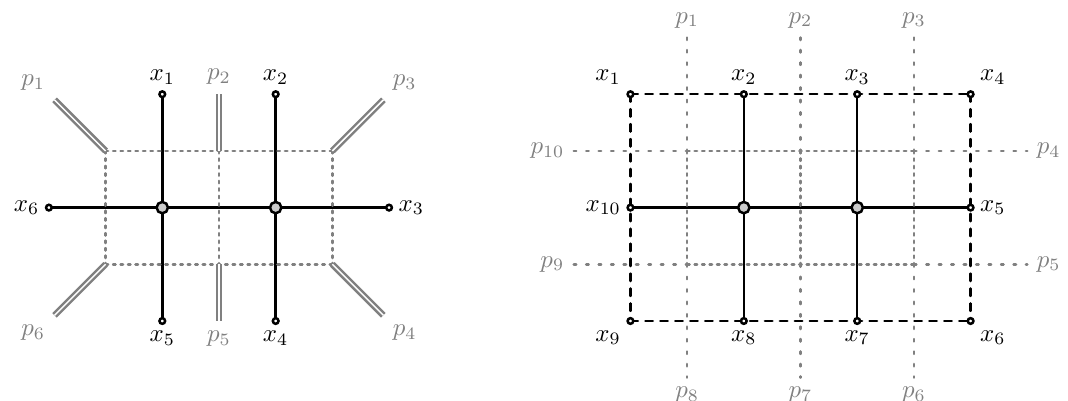
Figure 4 . Two-loop diagrams: double box topology in momentum variables (integration over momenta (cid:13)owing in loops) and its dual double cross topology in region momentum variables (in- tegration over position of the vertices | (cid:12)lled blobs). (A): all in(cid:13)owing momenta (depicted by double lines) are o(cid:11) shell, p 2 = x 2 = 0 at i = 1 ; : : : ; 6. (B): amplitude diagram for scattering of i ii +1 6 massless particles, i.e. the in(cid:13)owing momenta (depicted by loosely dotted gray lines) are light-like p 2 = x 2 = 0 at i = 1 ; : : : ; 10. These constraints are imposed by means of delta functions (cid:14) ( x 2 i ii +1 depicted by dashed black lines.